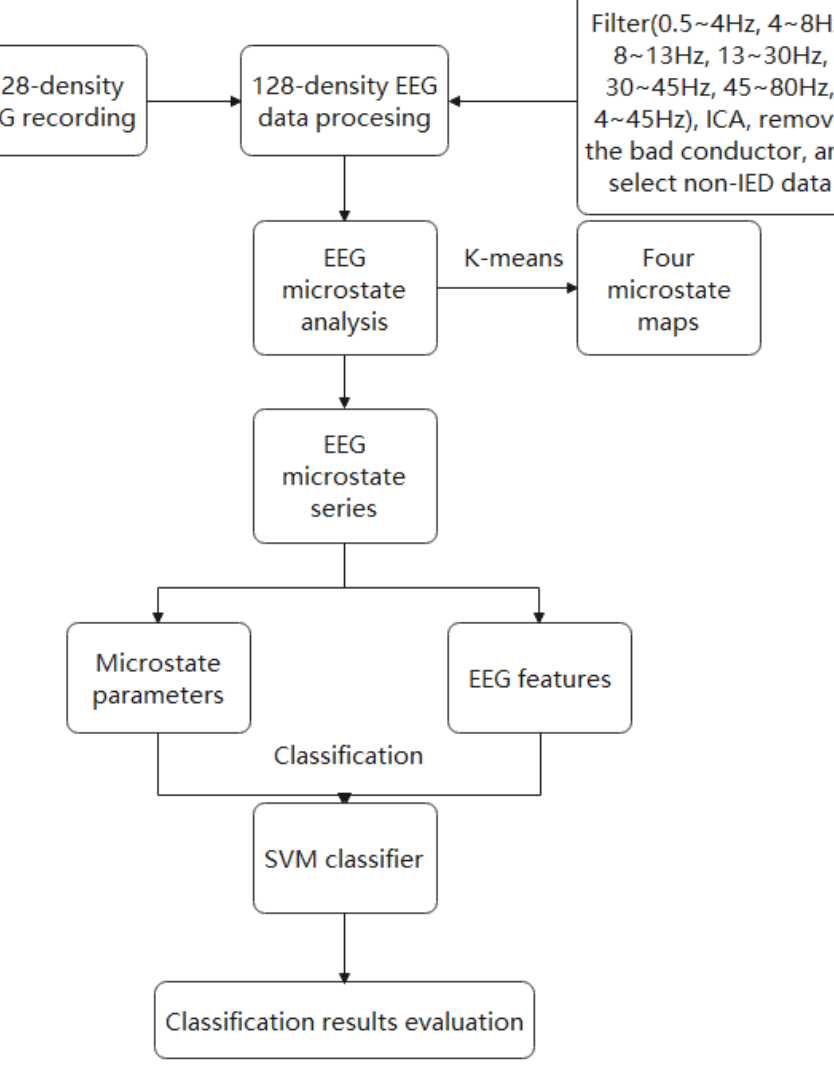
Figure 1. The technology roadmap of this